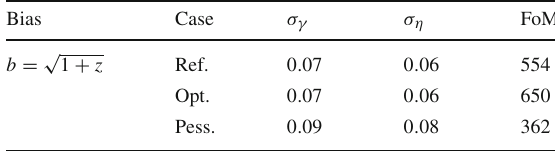
1 , σ w of Table 9. Yellow dots marg , 2 marg , 2